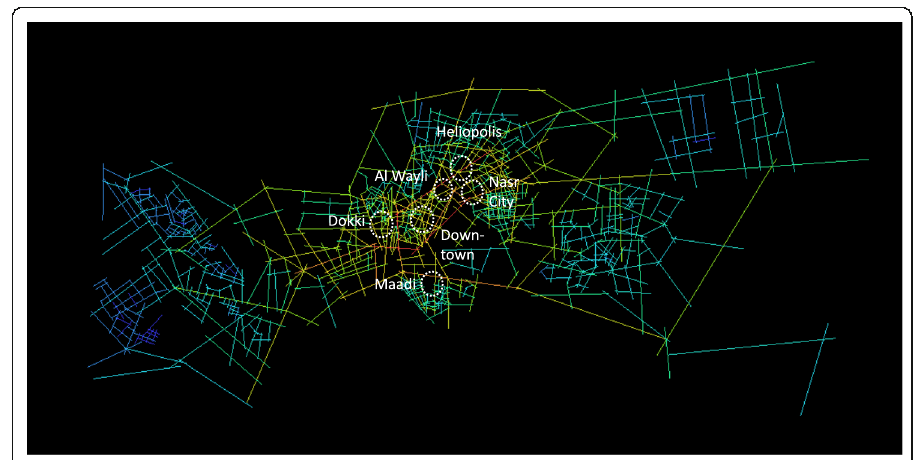
Fig. 4 Space syntax integration analysis ( Rn ), representing the spatial integration of the areas where co- working spaces emerged in Cairo post 2011 till 2014; red color indicates higher values of integration, blue color indicates segregation and lower values. Elaboration by